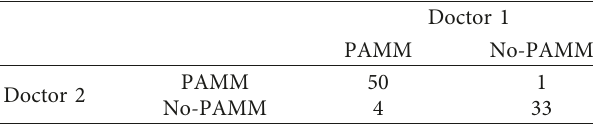
Table 1: Consistency between the two doctors for the evaluation of